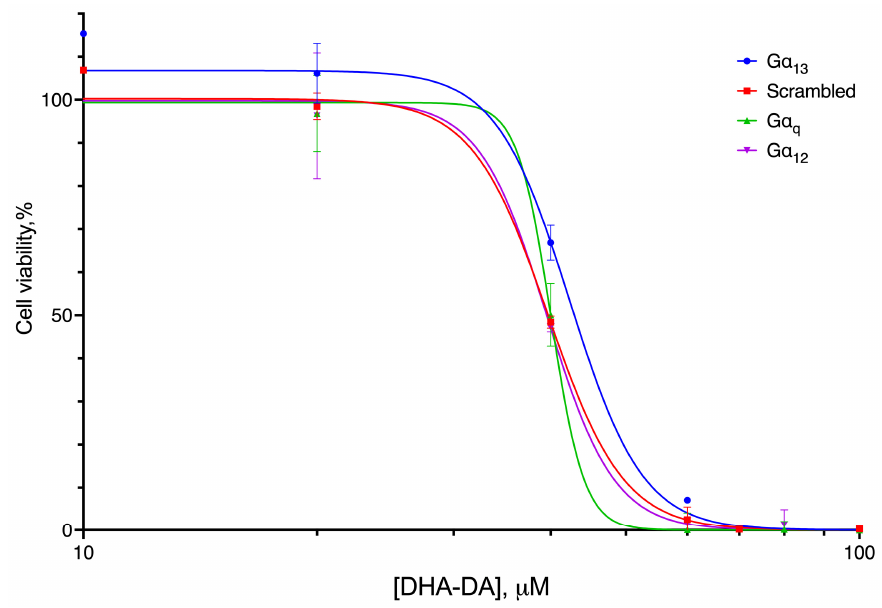
Figure 16. Cytotoxicity of DHA-DA for the MDA-MB-231 line with the knockdown of G α subunits. The cells were treated for 72 h after siRNA transfection; incubation with the substance was for 24 h. MTT test data, mean±standard error, amalgamated data of n = 4 experiments.